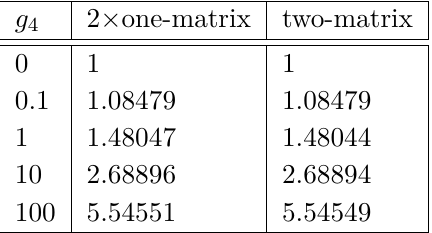
Figure 2. Spectrum of the large N Hermitian one-matrix quantum mechanics.